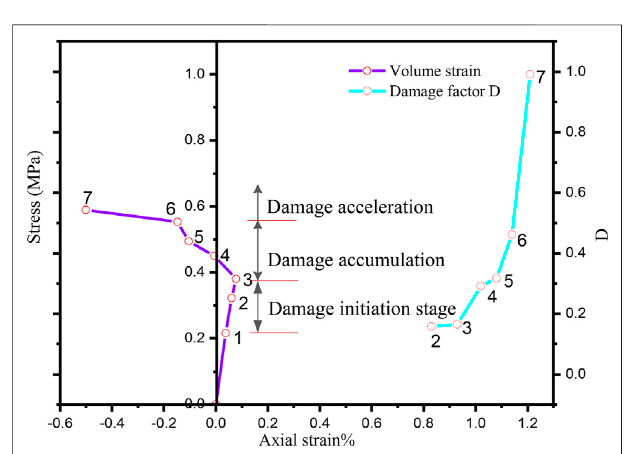
FIGURE 8 | Volume strain curve and damage